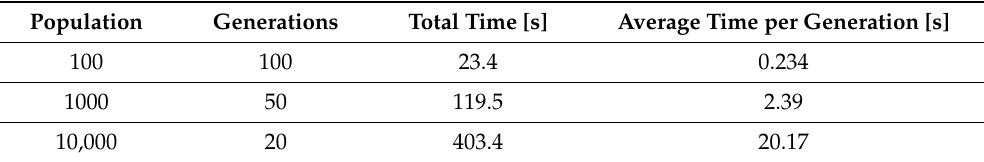
Table 2. The execution times of various configurations, averaged over ten runs, with an average time per generation and the total execution time given.